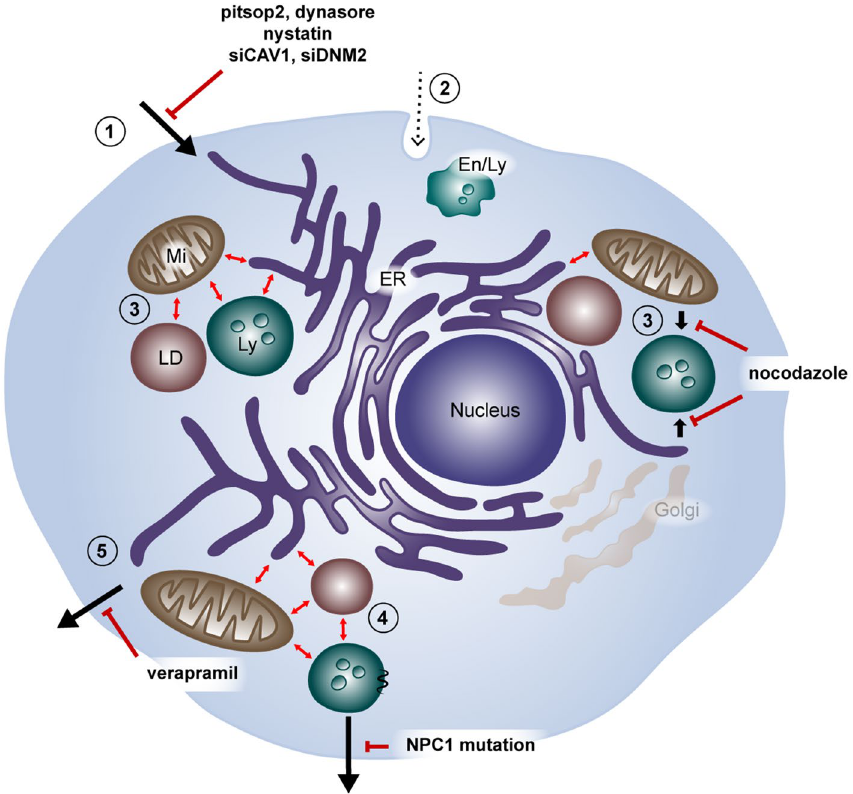
Figure 8. Trafficking itinerary of Sterolight probe. ( 1 ) Energy independent uptake likely occurs via passive diffusion, penetration or protein carrier-mediated diffusion. It is inhibited by pitstop 2, dynasore, and nystatin inhibitors or by siRNAs-induced knockdown of caveolin-1 and dynamin-2 expression. ( 2 ) Endocytosis- mediated uptake seems unlikely (dash line). ( 3 ) Intracellular distribution of the probe occurs very quickly and is likely facilitated by membrane contact sites (MCS) between distinct organelles (shown with red double arrows). Probe temporarily occurs in ER and mitochondria (Mi) and within 1–6 h proceeds to lysosomes (Ly). Transition to lysosomes is blocked by microtubule depolymerizing drug nocodazole. Distribution and transfer inhibition of probe from ER to lysosomes resembles closely intracellular traffic of non-caveolar caveolins. ( 4 ) Prolonged incubation results in the accumulation of probe excess in lipid droplets (LD). ( 5 ) Probe efflux is energy dependent and requires functional NPC1 cholesterol transporter. Cells with mutated NPC1 are not able to release accumulated probe from lysosomes as effectively as non-mutated cells. The involvement of ABC transporters in probe efflux is demonstrated by its inhibition with